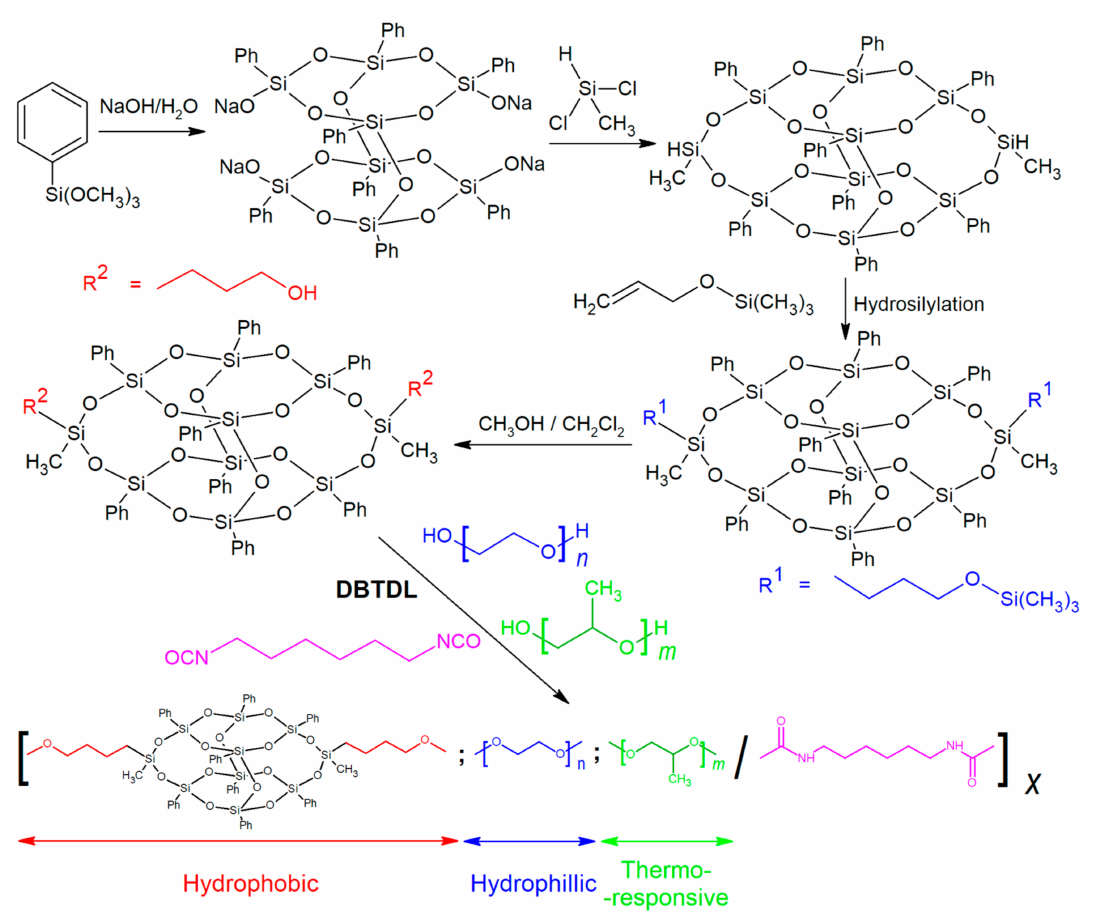
Figure 4. Schematic representation of BPOSS synthesis and the building blocks of obtained polyurethane. Reprinted with permission from Han, Y.; Xu, C.; Shi, H.; Yu, F.; Zhong, Y.; Liu, Z.; Loh, X.J.; Wu, Y.L.; Li, Z.; Li, C. (2021) Chem. Eng. J.,